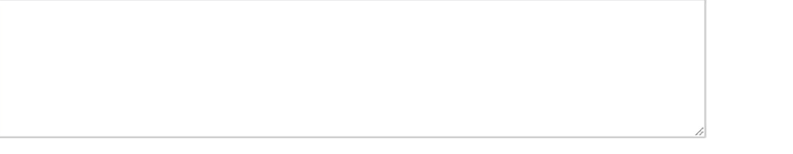
Fig 4. The statistics